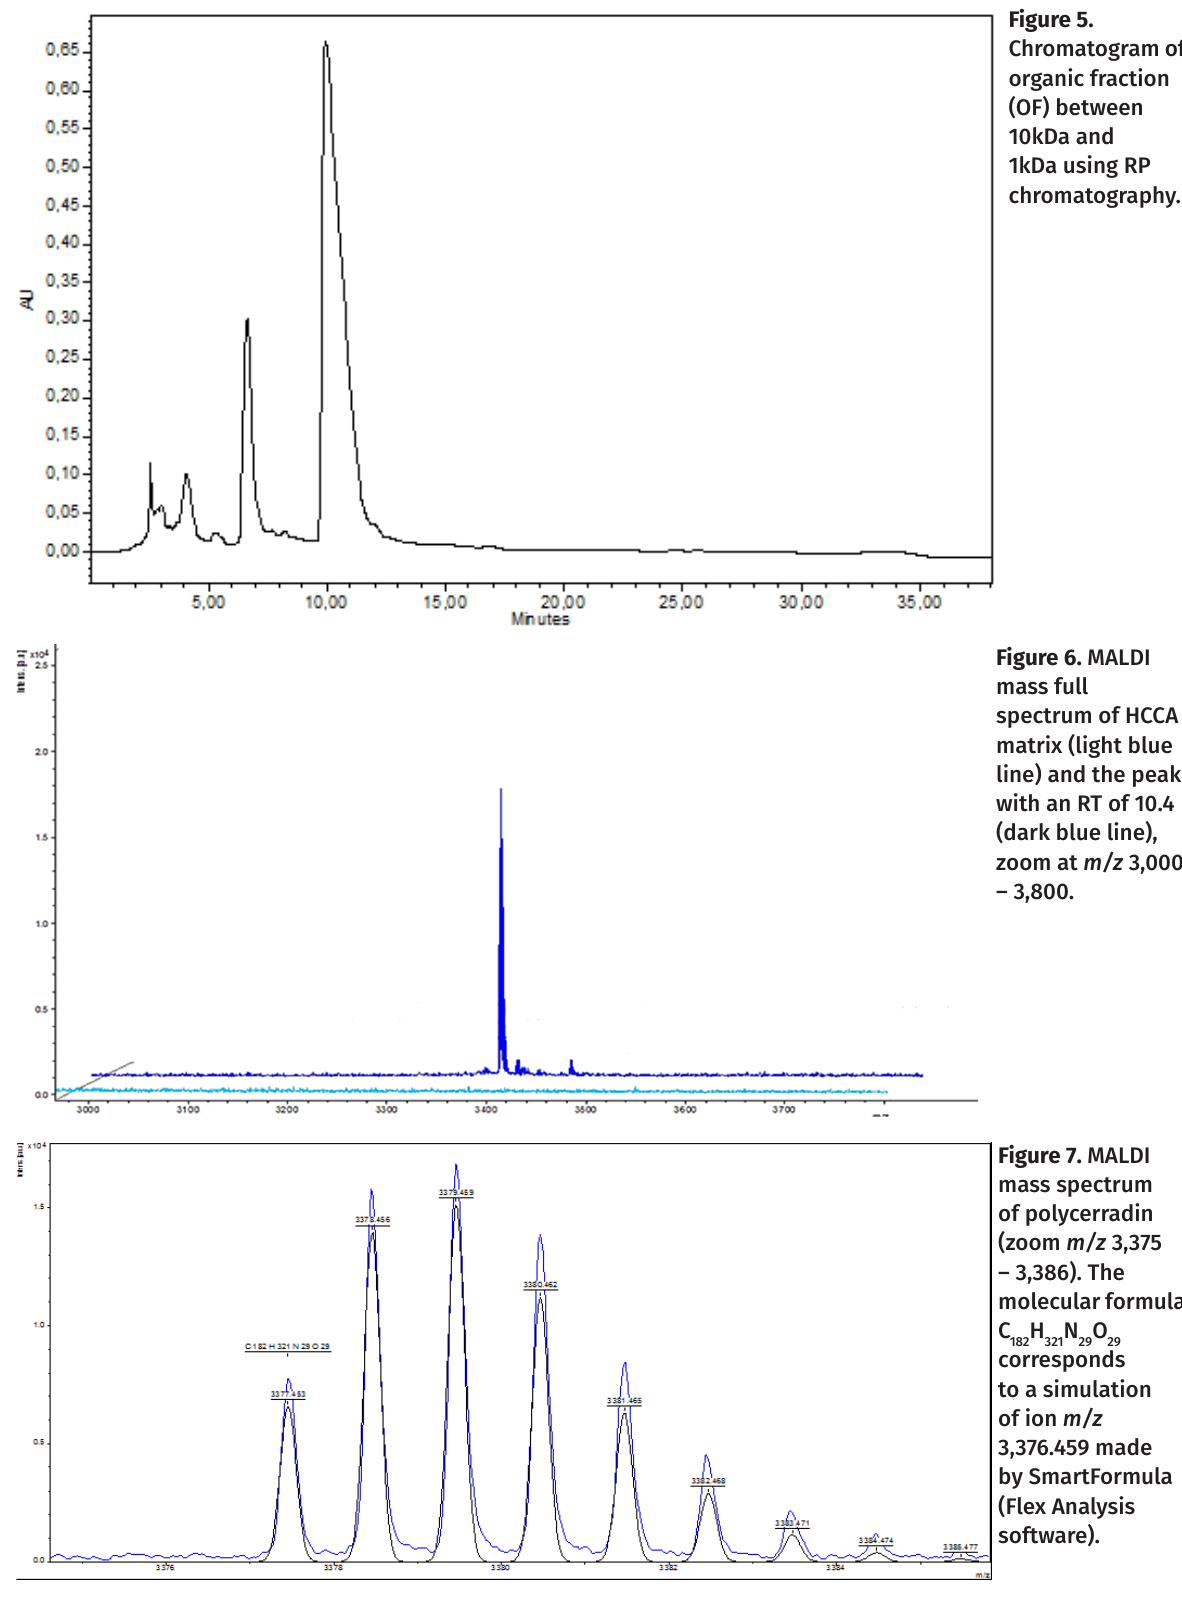
Figure 5. Chromatogram of organic fraction (OF) between 10kDa and 1kDa using RP chromatography.